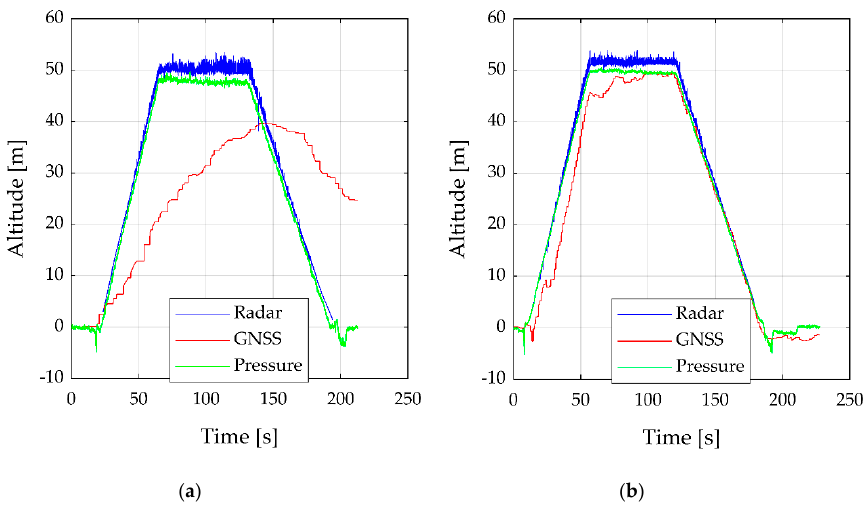
Figure 7. Comparison of the altitude estimation with radar sensor ARS-404, global navigation satellite system (GNSS) sensors, and pressure sensors. The first flight ( a ) shows the flight with the sensor shield GPS-PIE and ( b ) with the OzzMaker shield.